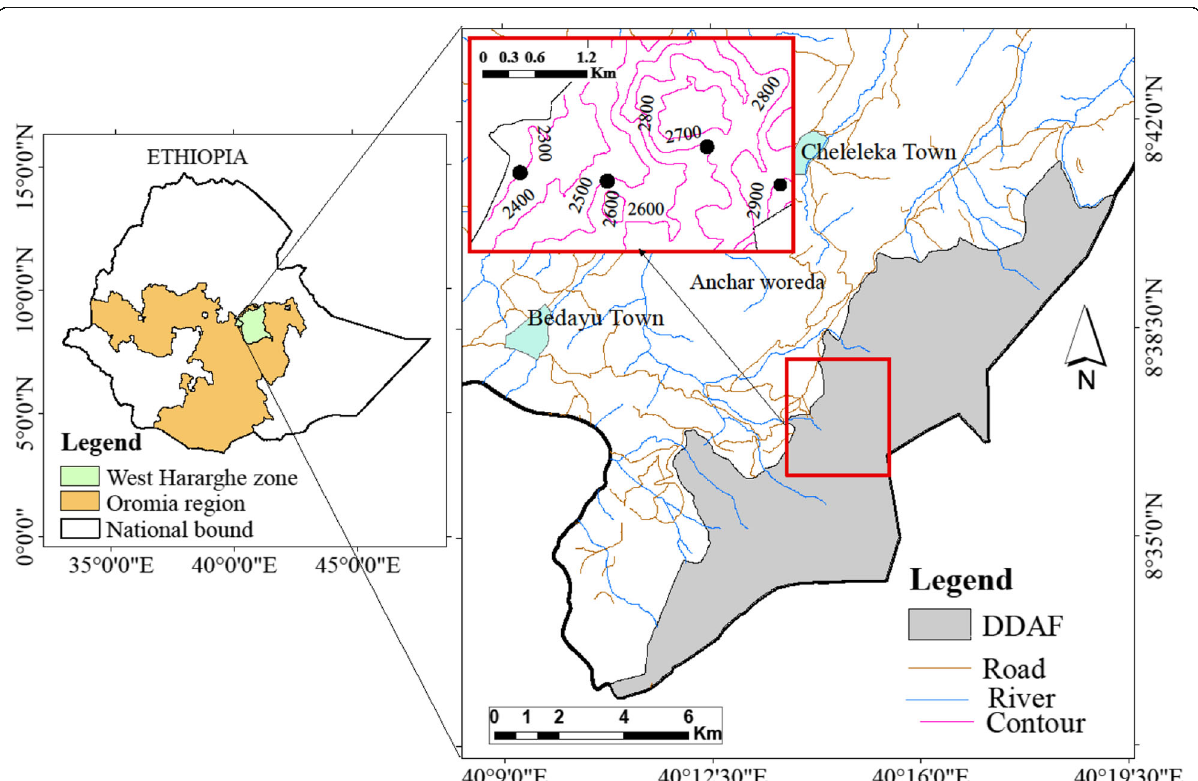
Fig. 1 Map of study area and location of sampling sites. The red rectangle represents the study site; the black circles represent individual horizontal transect sampling sites (points). DDAF, Dindin dry evergreen Afromontane